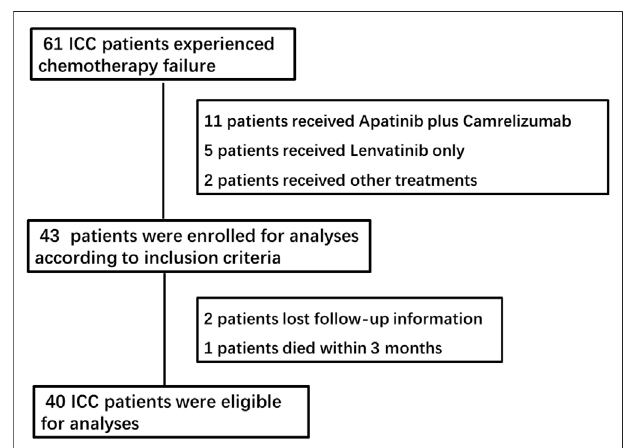
FIGURE1 | Flowchart ofthe study. Ef fi cacy and safety ofthe